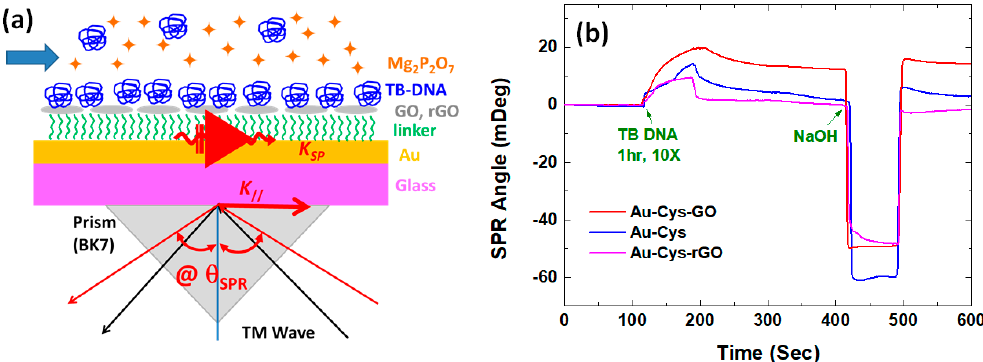
Figure 6. ( a ) Experimental scheme of the SPR biosensor integrated with loop-mediated isothermal amplification (LAMP) for detection of tuberculosis bacterial DNA (TB DNA). ( b ) SPR response on Cys-GO, Cys-rGO, and Cys-linker sensing surface (adapted with permission from Reference [38], copyright SPIE).